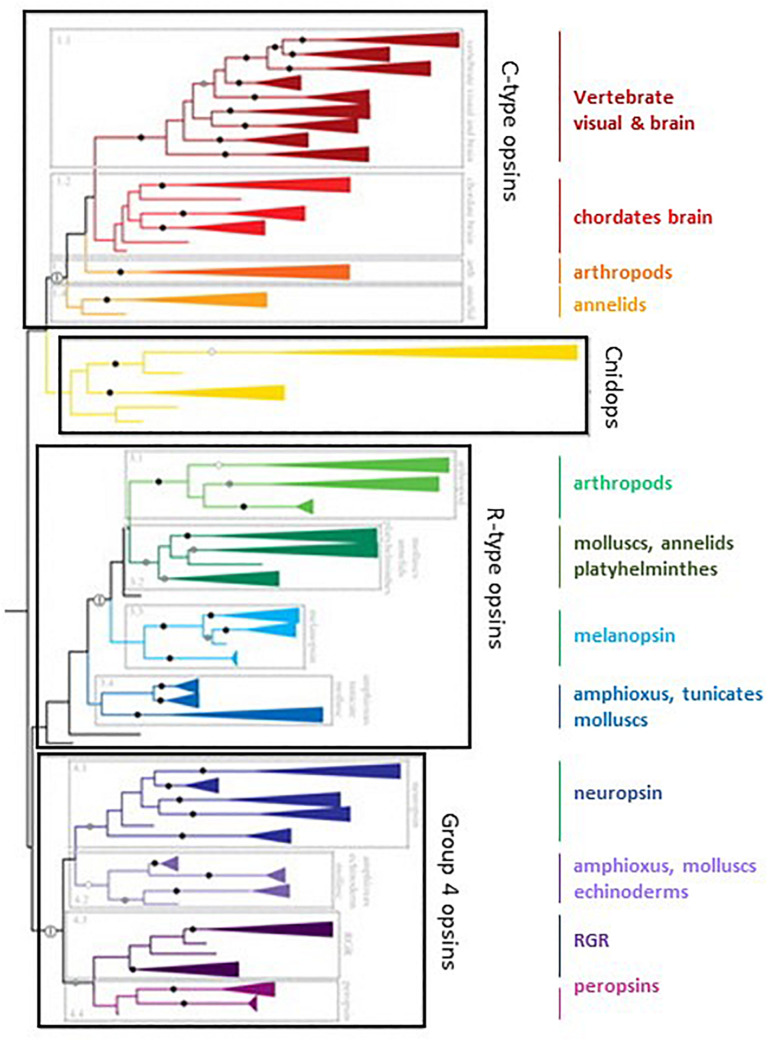
The family of opsins in the tree of evolution. C-opsin family includes the vertebrates visual and brain opsins (Rh1, Rh2, SWS1, SWS2, M/LWS, pinopsins, parapinopsins, vertebrate ancient and parietal opsins), the chordates’ brain opsins (teleost multiple tissue opsins (TMTs), encephalopsins and uncharacterized amphioxus and urchin opsins), the arthropod opsins (honeybee ptersopsin, and uncharacterized insect and Daphnia pulex opsins), and the annelids group (uncharacterized Platynereis brain and urchin opsins). Cnidops family includes ctenophore and cnidiarian opsins. R-type opsins include the arthropod visual pigments (M, LWS, and SWS), the annelid, Platyhelminthes and mollusc visual pigments, the melanopsins (vertebrates’ melanopsin 1 and 2, and amphioxus sequences) and uncharacterized tunicate, amphioxus and mollusc opsins. Group 4 Opsins include neuropsins (four separate clades), amphioxus, sea urchin and scallop opsins, RGR (uncharacterized mollusc opsins) and peropsins (amphioxus and hemichordate opsins). See text and (Porter et al., 2012) for more details. Modified from Porter et al. (2012). No special permission required.